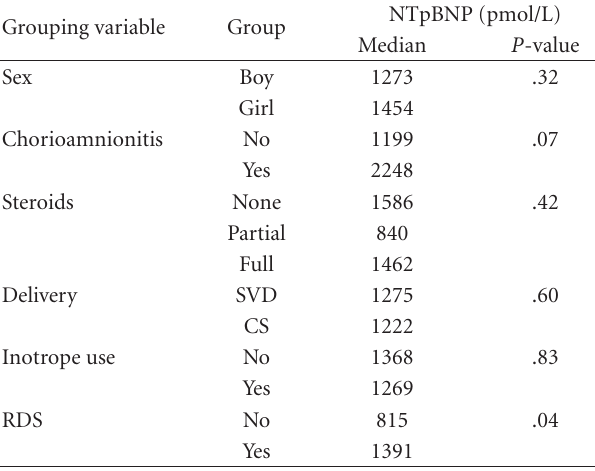
Table 2: Influence of antenatal and factors on NTpBNP levels at 12 hours (Mann Whitney U test was used to compare